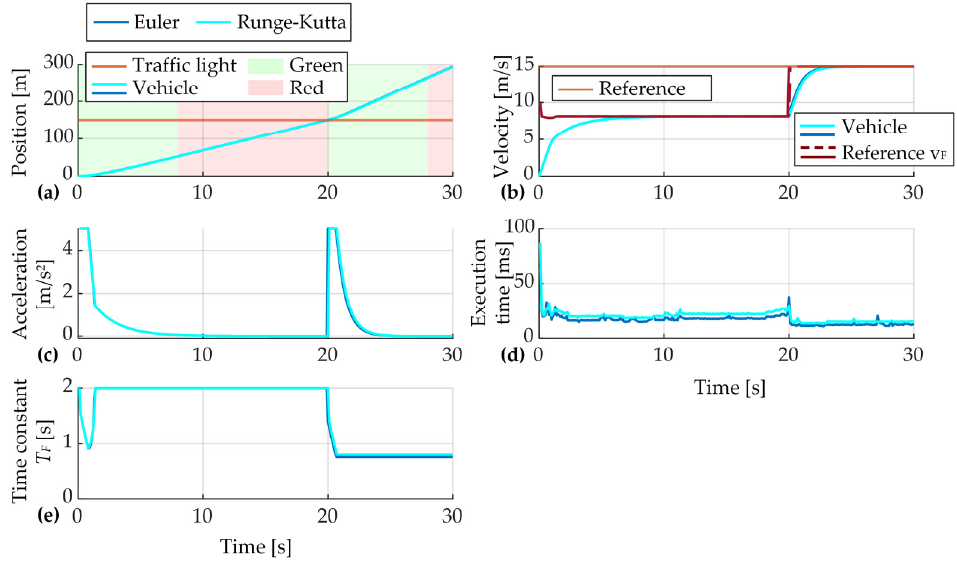
Figure 11. NMPC system responses for different time-discretization methods applied. Subfigures show position ( a ), velocity ( b ), acceleration ( c ), execution time ( d ) and time constant control input ( e ).